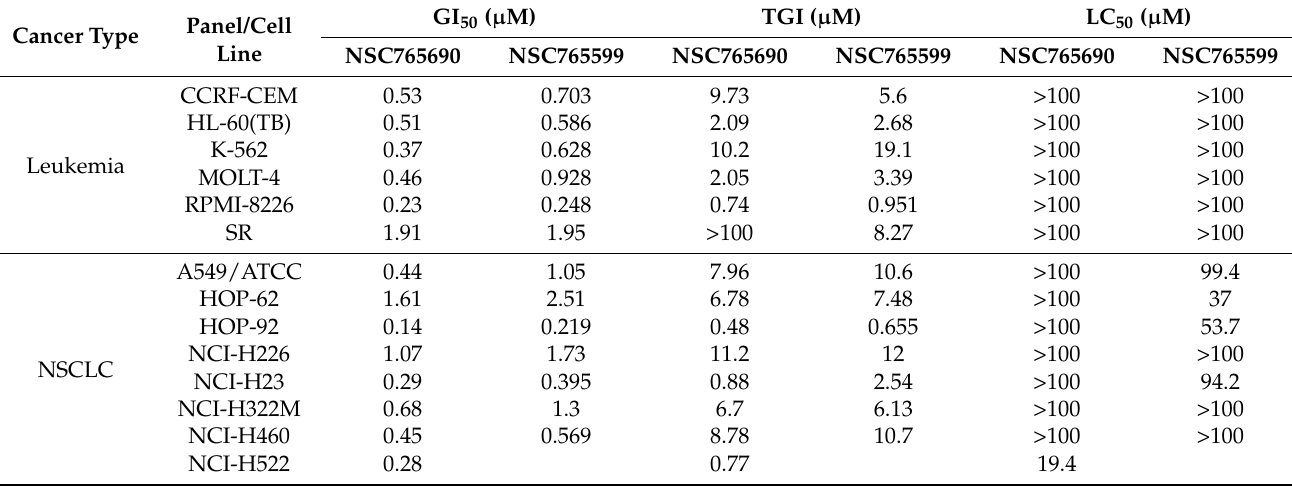
Figure 4. Dose–cytotoxic response curves of NSC765599 against panels of 60 NCI human cancer cell lines. The growth percentage value of +100 on the Y-axis represents the growth of untreated cells, the 0 value represents no net growth, while −100 represents the complete death of cells. Table 1. Anti-proliferative and cytotoxic activities of NSC765690 and NSC765599 against panels of NCI60 human cancer cell lines.